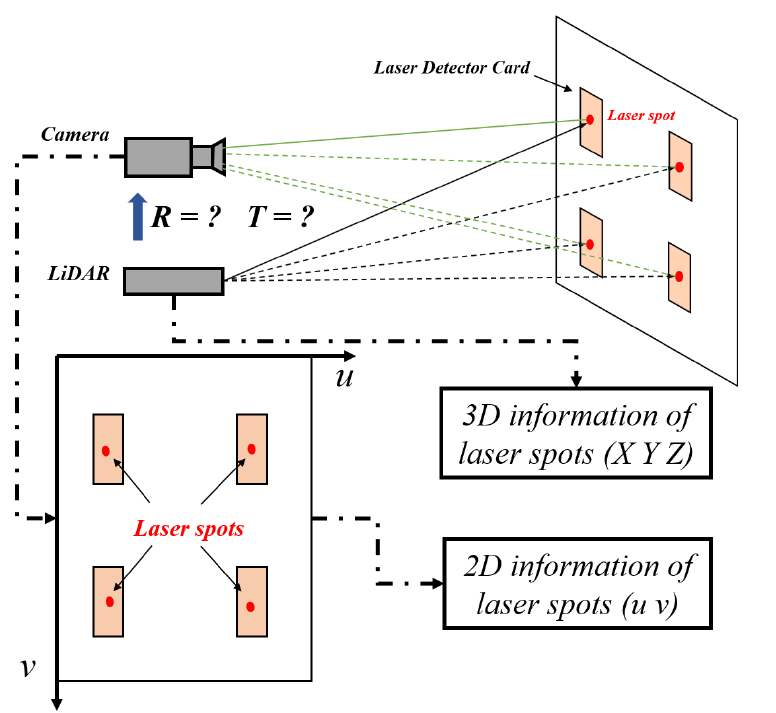
Figure 2. Schematic diagram of the calibration based on the laser detector